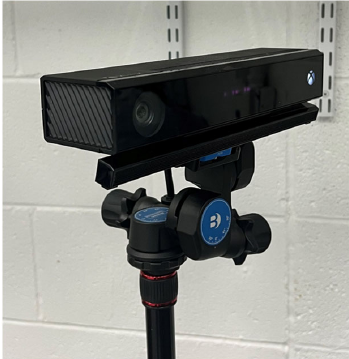
Figure 6. Kinect v2 ToF sensor mounted to a tripod using a 3 ‐ way geared head.